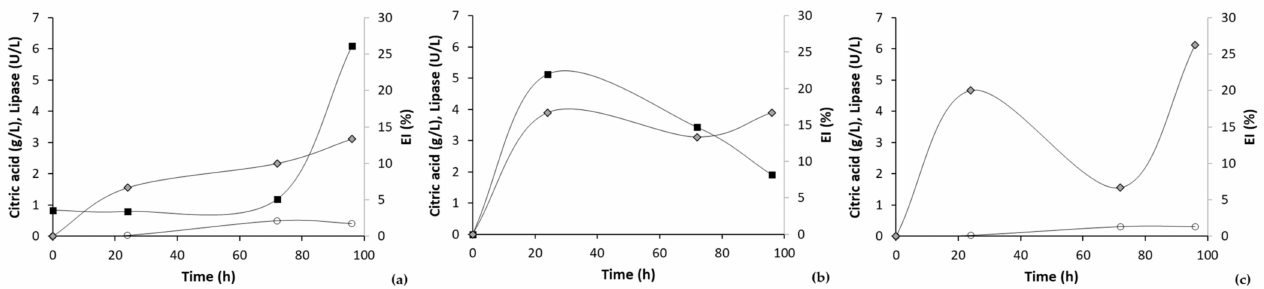
Figure 9. Bioproducts concentration profiles obtained by Y. lipolytica IMUFRJ 50682 in medium with 2% glucose and 1% v / v oil ( a ), in medium with 1% v / v oil ( b ), and in medium with 2% glucose ( c ). Citric acid (open circles), lipase activity (black squares), emulsification index (EI) (grey diamonds).